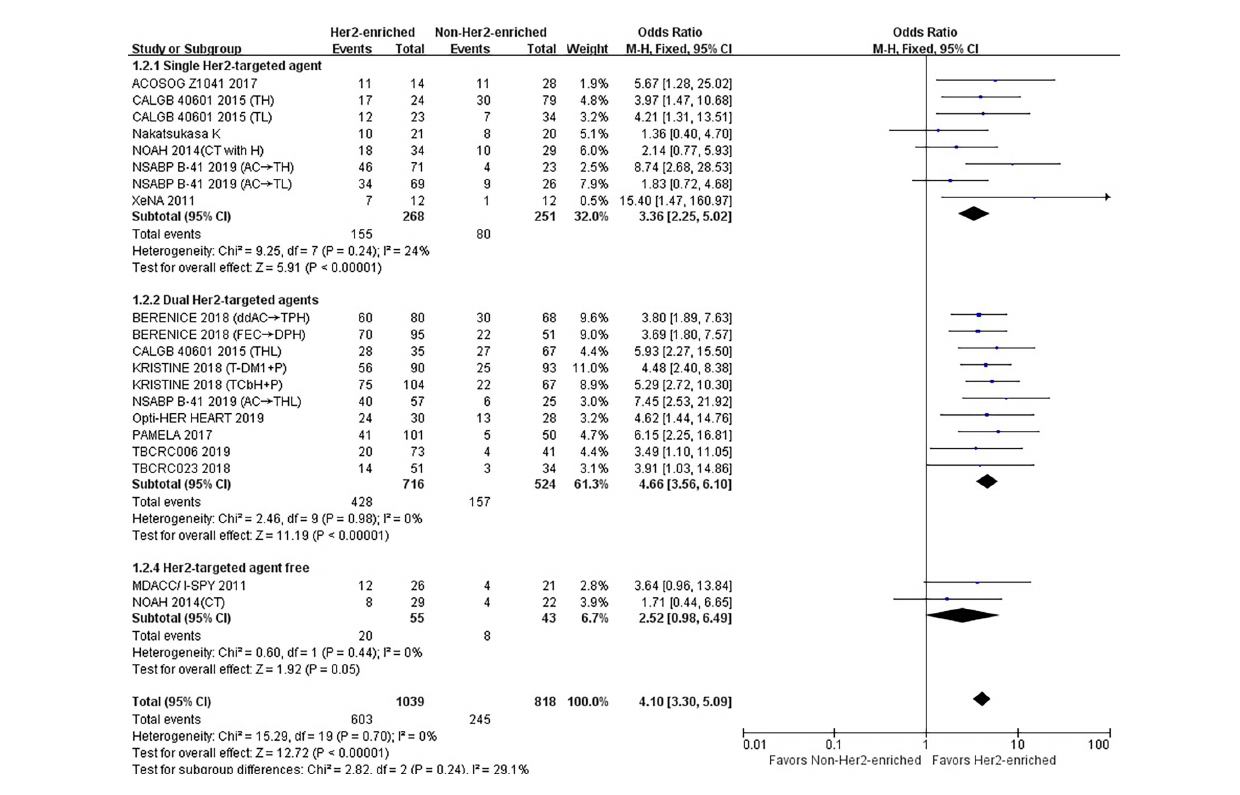
FIGURE 3 | Forrest plot of odds ratio (OR) used to evaluate the correlations between intrinsic molecular subtype subgroups (HER2-enriched vs. non-HER2-enriched) and pCR as based on the number of HER2-targeted therapies used. CI, con fi dence interval; HER2, human epithelial growth factor receptor 2; pCR, pathological complete